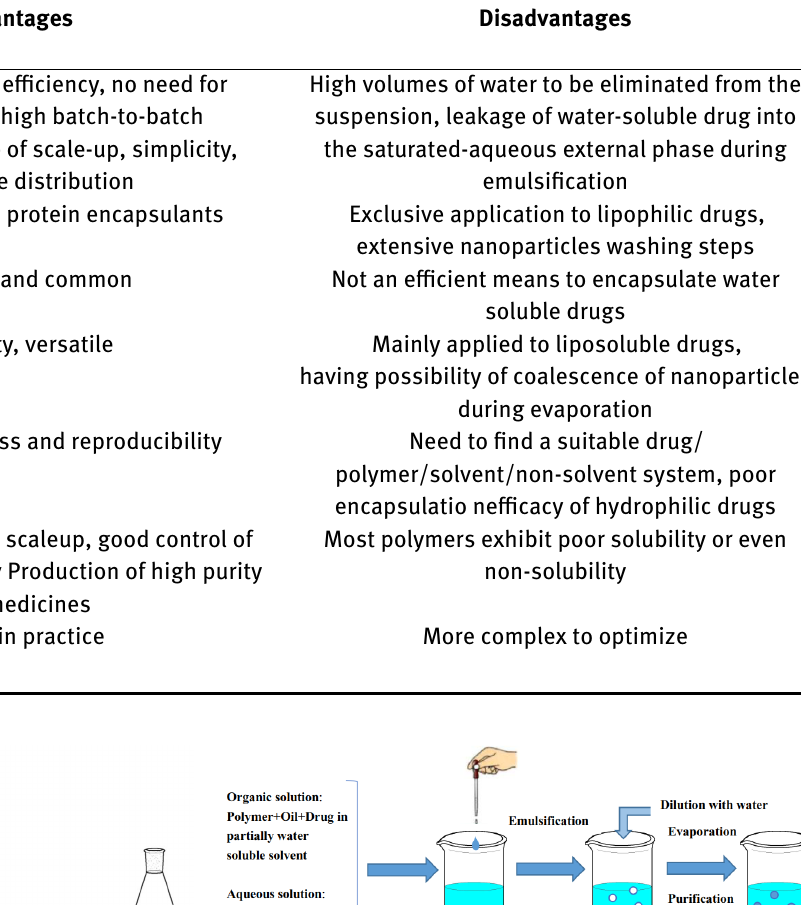
Table 2: Advantages and disadvantages of formulation of polymer-based nanoparticles Formulation